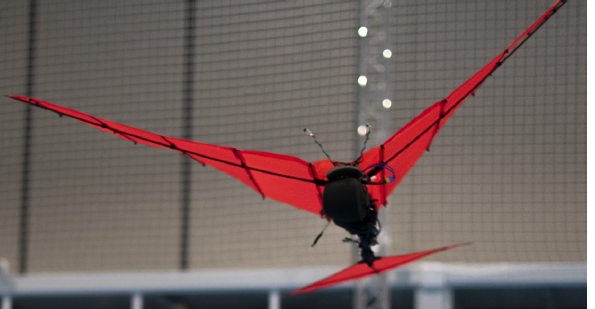
Figure 1. Prototype of Ornithopter, Named "Powerbird”, Developed for the GRIFFIN